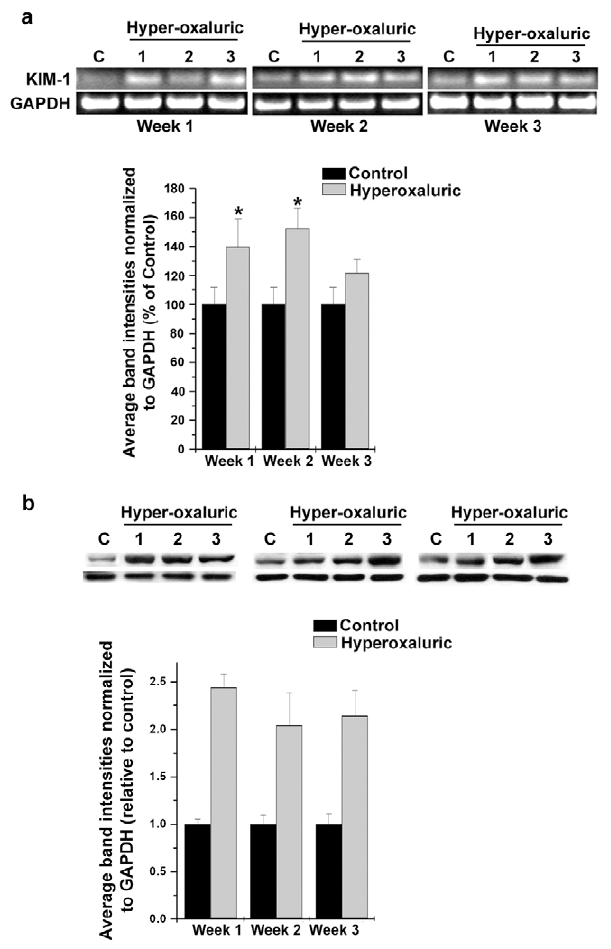
Figure 3. Hyper-oxaluric rats have increased mRNA and protein levels of KIM-1 in renal tissue. ( a ) KIM-1 mRNA levels were detected by relative quantitative RT-PCR in kidney tissue of control and three individual hyper-oxaluric rats. Representative gel images from three individual PCRs are shown ( Top Panel ). Quantitative representation of relative KIM-1 mRNA expression across the hyper- oxaluric group compared to control is shown in the Bottom panel . Each data point represents mean + / 2 S.D. of three experiments (*indicates p , 0.05 compared to control, n=3). ( b ) Representative gel images from three individual western blots are shown ( Upper Panel ). Quantitative representation of the relative amounts of KIM-1 protein in the kidney tissue is shown in the lower panel . Each data point represents mean + / 2 S.D. of three blots (*indicates p , 0.05 compared to control, n=3).